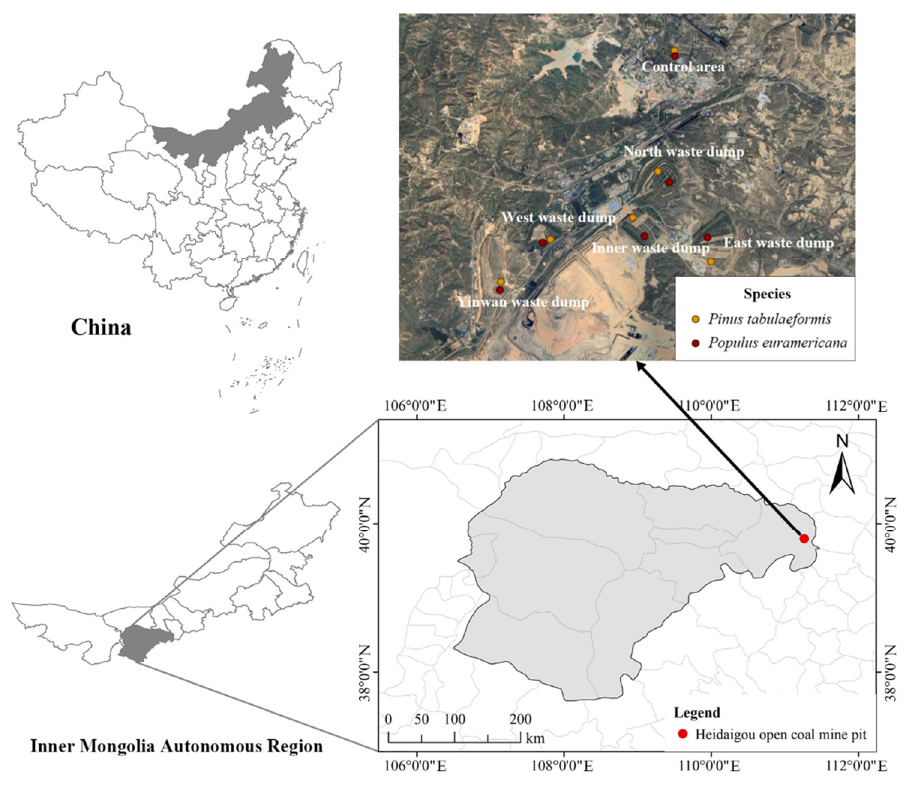
Figure 1. Location of the study area.